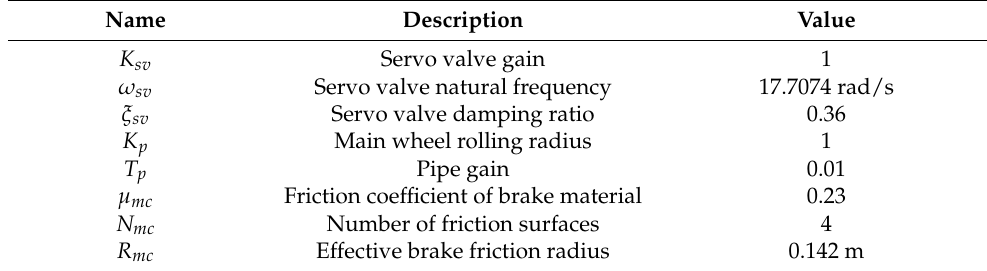
Table 6. Parameters of the hydraulic servo